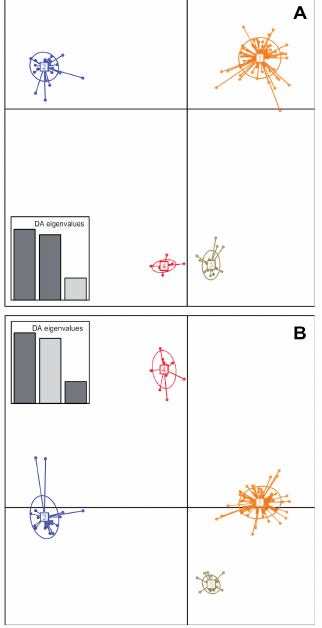
Figure 2. Genetic structure of Xanthomonas citri pv. citri lineage 1 in the SWIO region based on the discriminant analysis of principal components (DAPC) of microsatellite data. Numbers and colours represent the four genetic clusters retained from Bayesian information criterion (BIC) values. Strains from the Comoros and the Mascarenes grouped in a single genetic cluster (GC1), whereas strains from the Seychelles grouped in three distinct clusters. ( A ) Scatterplot representing axes 1 and 2 of the DAPC. ( B ) Scatterplot representing axes 1 and 3 of the DAPC. A subset of haplotypes originating from the Comoros and the Mascarenes (GC1, minor clusters and singletons) were used to avoid too large within-cluster variance (large haplotype number disequilibrium among